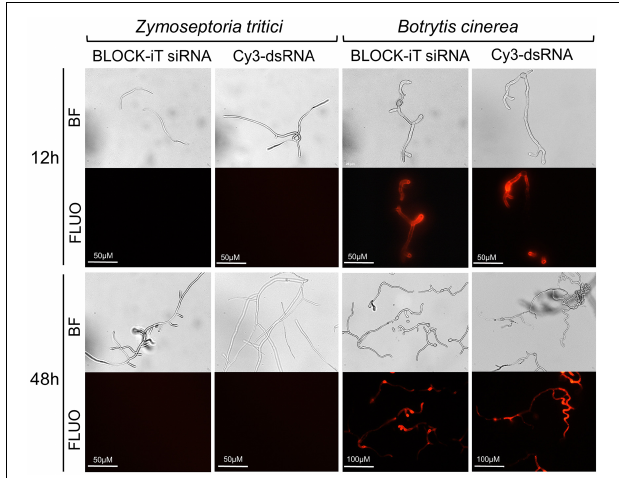
FIGURE 7 | Assessment of dsRNA molecules uptake in Zymoseptoria tritici and Botrytis cinerea . Uptake of fluorescently labeled short dsRNA (Alexa Fluor Red BLOCK-iT siRNA) or 250-long long Cy3-labeled dsRNA against GFP was monitored at 12 and 48 h of co-incubation using microscopy. Representative images from a single experiment are depicted as captured with bright field (BF) and fluorescent (FLUO) absorption 555 nm, emission 565 nm) settings. The experiment was repeated 3 times with similar